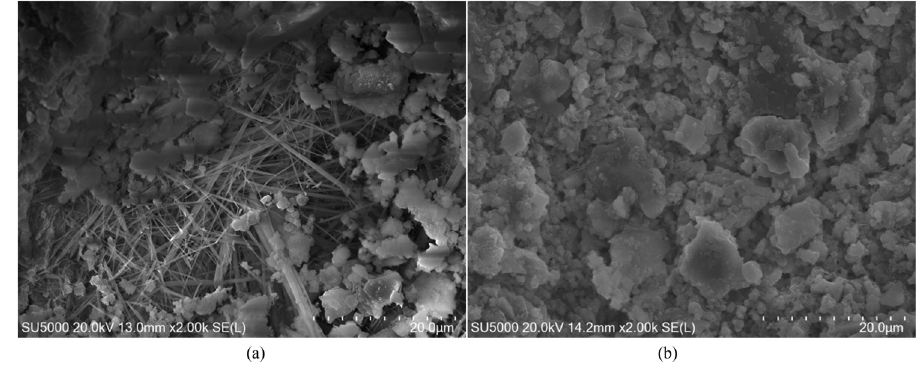
Figure 24: Micro - morphology of RA before and after NS modi fi cation. ( a ) NS - 0, ( b ) NS - 2%.